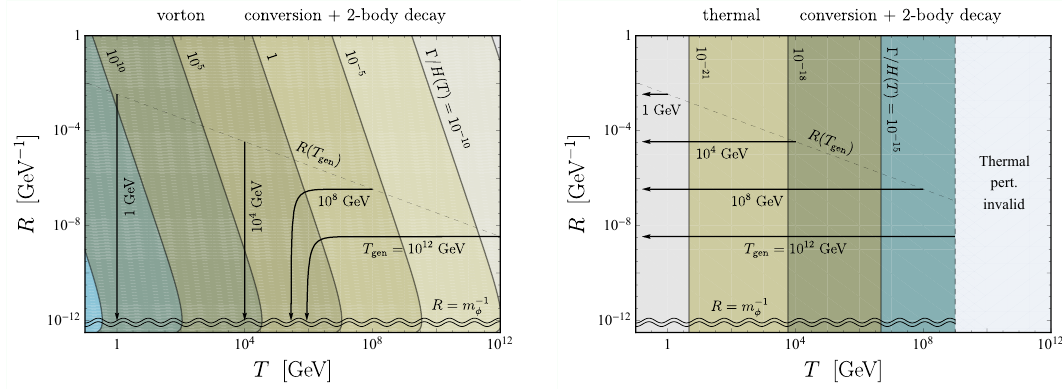
Figure 9 . The time evolution of the vorton radius R with various production temperatures in the cases of the vorton curve (left) and the thermal curve (right). The model parameters are set to be E = m φ = 10 12 GeV and m σ = 10 2 GeV . The black lines with arrows indicate the trajectories of vorton radii produced at T = T . Each contour means the specified values of decay widths over gen the Hubble